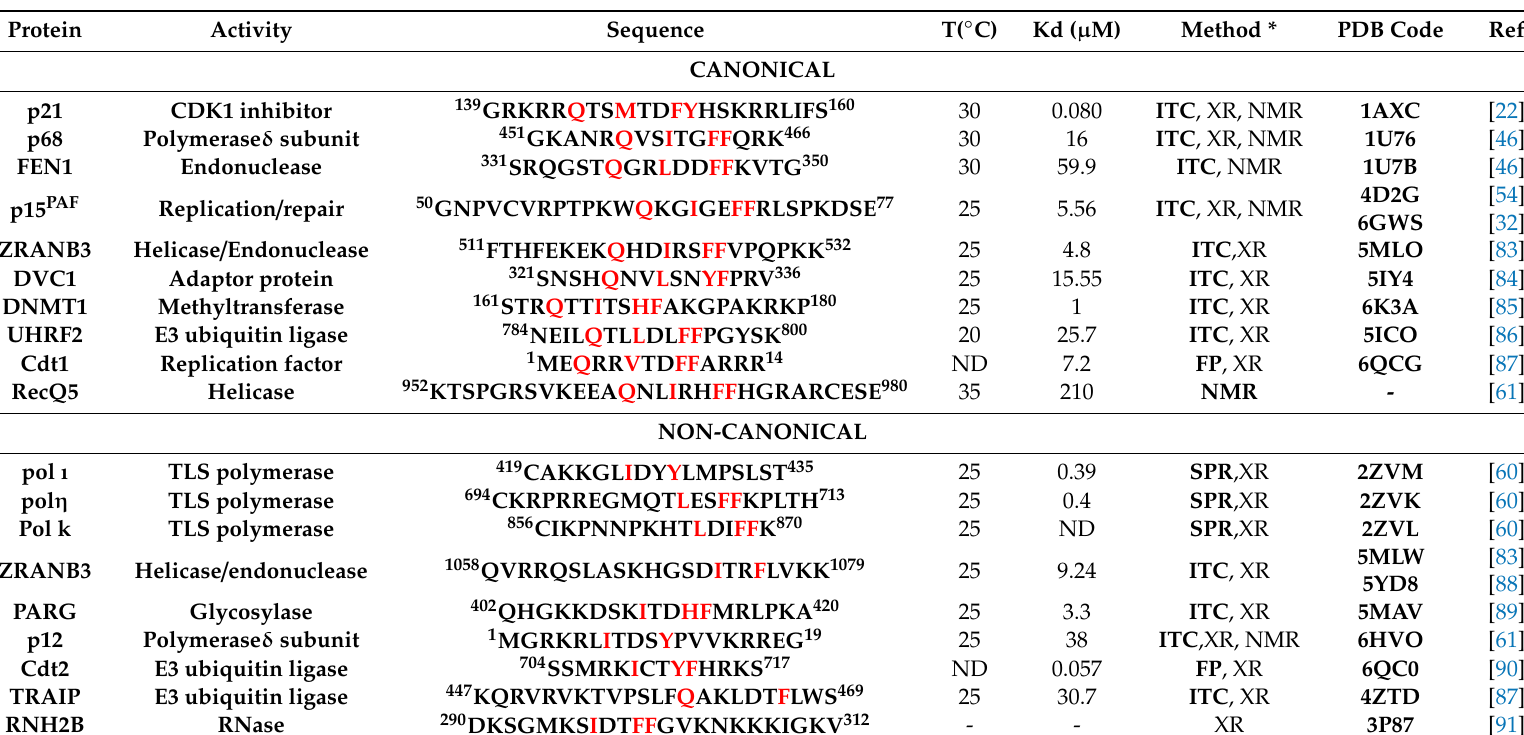
Table 2. A summary of protein-PCNA interactions validated by structural and / or quantitative methods. The conserved residues of the PIP box motif are marked in red. Protein Activity